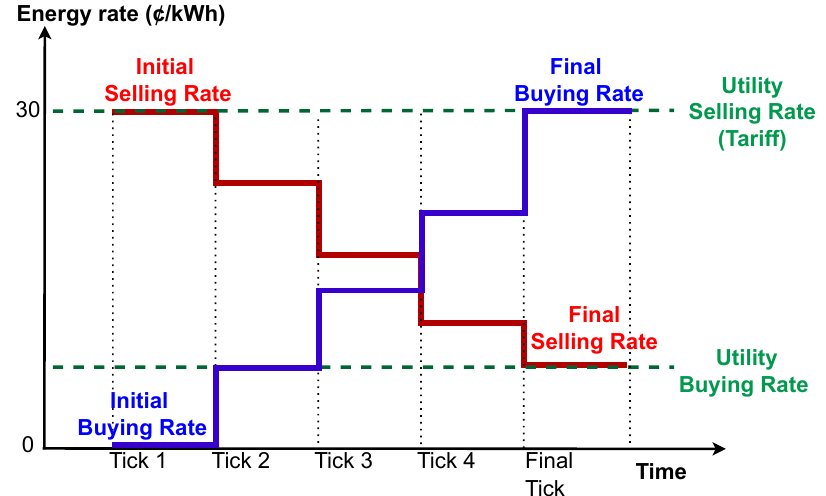
Figure 4. Example of bidding strategy from a consumer asset (blue), offering strategy from a genera- tion asset (red), and utility as a price maker (green) within a market slot.